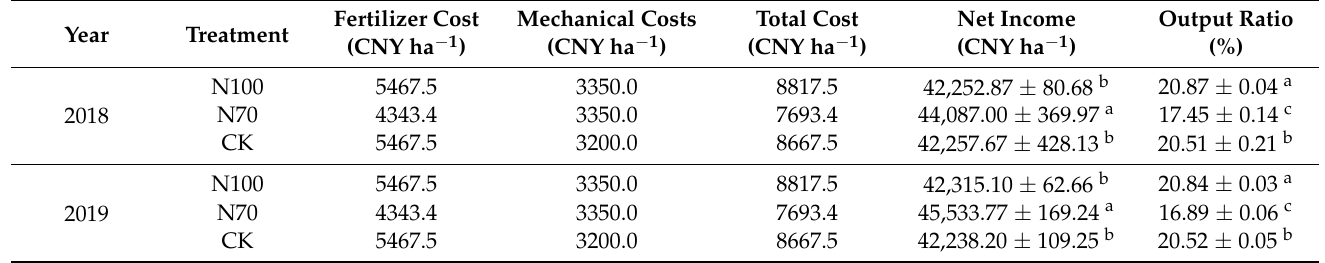
Table 8. Effect of smash ridge tillage and reducing nitrogen fertilizer on economic